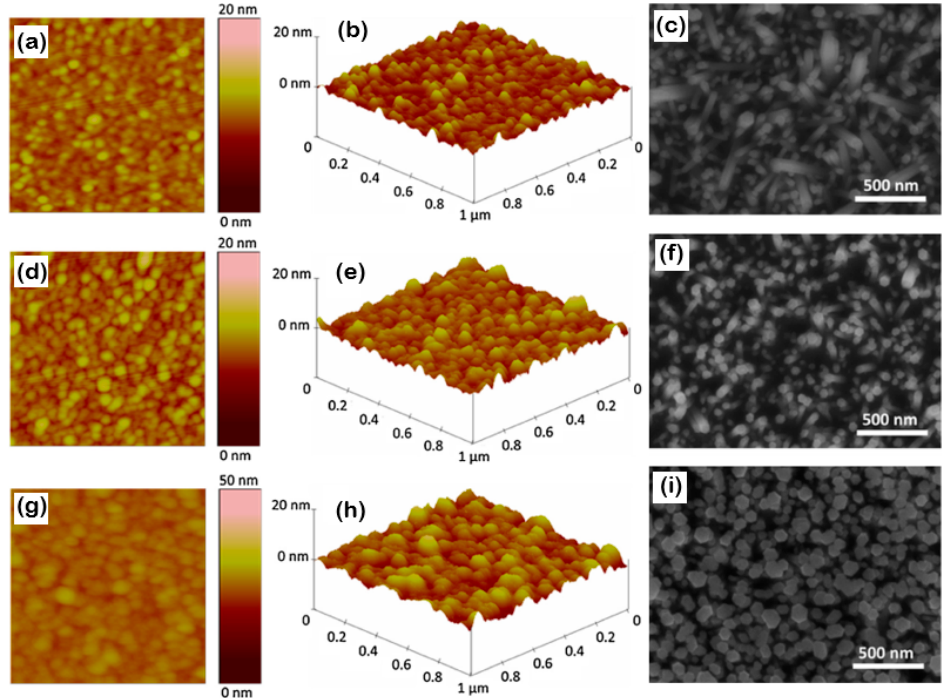
Figure 6. AFM (2D, 3D images) for ZnO seed layer sputtered for 10 min, 15 min, and 20 min, ( a – h ) and ( c ) top view FE-SEM view of ZnO nanorod arrays grown for ( c ) 10 min, ( f ) 15 min, ( i ) 20 min, respectively. Reprinted with permission from ref. [68]. Copyright 2016 Elsevier.